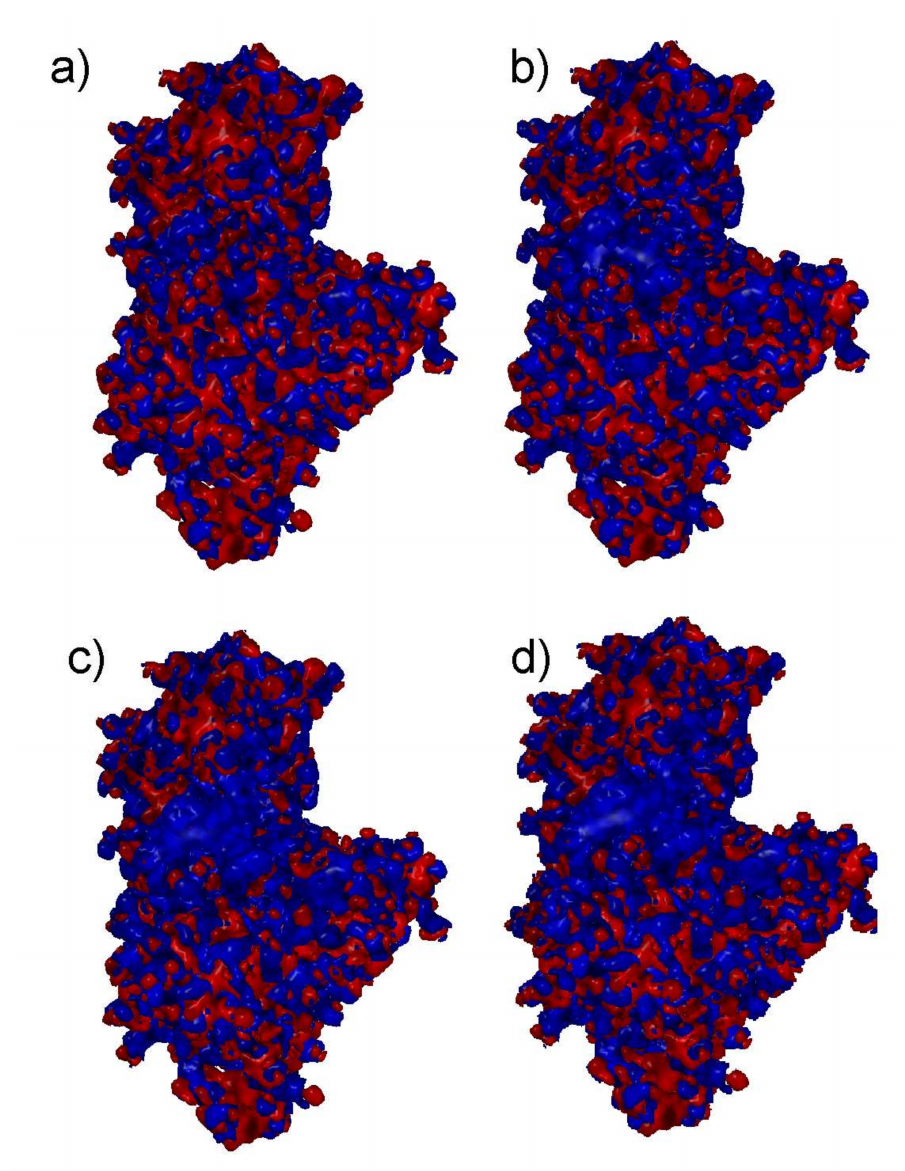
Figure 3. Electrostatic potential map of HSA where blue and red represent positively and negatively charged regions, respectively. Effects of different ions are presented: ( a ) no ions, ( b ) Na + , ( c ) Ca 2+ , ( d ) Mg 2+